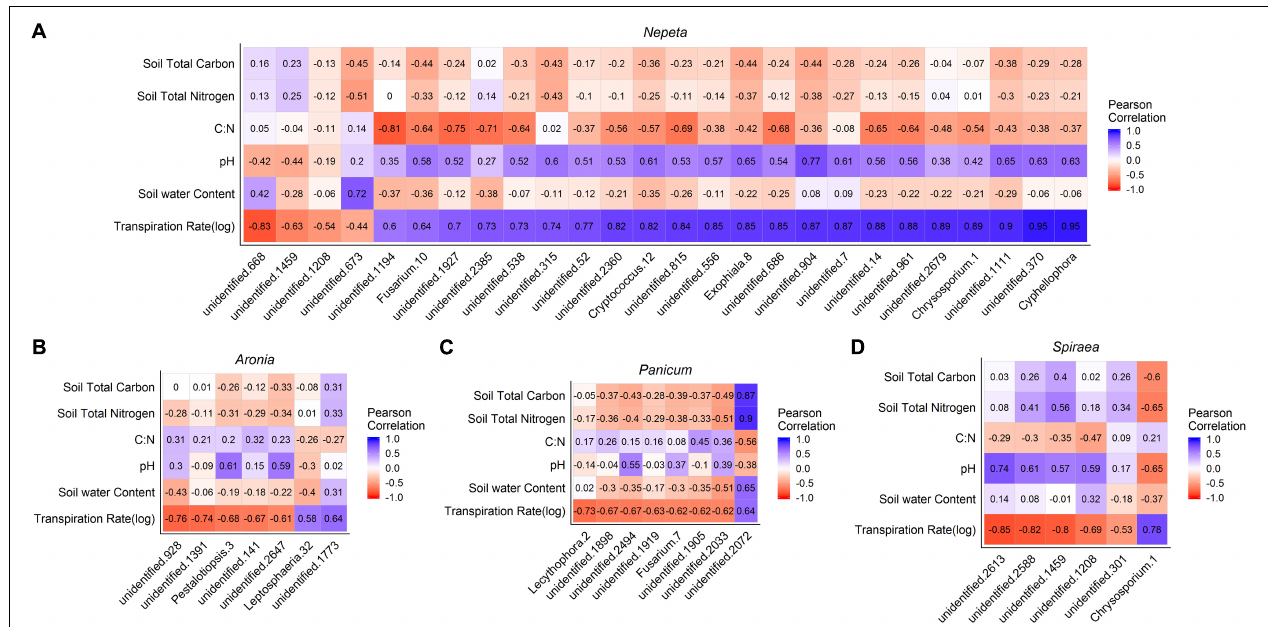
FIGURE 6 | Pearson correlation matrix of fungal OTUs that were signficantly correlated with the plant transpiration for Nepeta (A) , Aronia (B) , Panicum (C) , and Spiraea (D) . Eupatorium was not included due to low sample sizes.